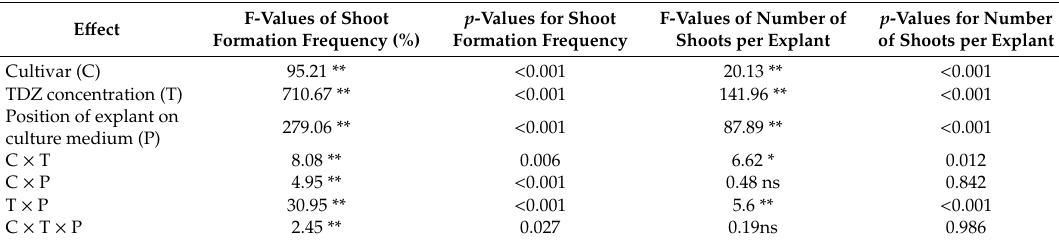
Table 1. The variance analysis of investigated factors on shoot formation frequency and number of shoots per explant.